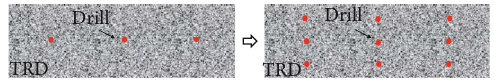
Figure 15: The coring position in